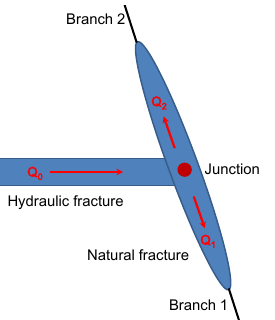
Figure 4. Schematic diagram of a T-shaped fluid-driven